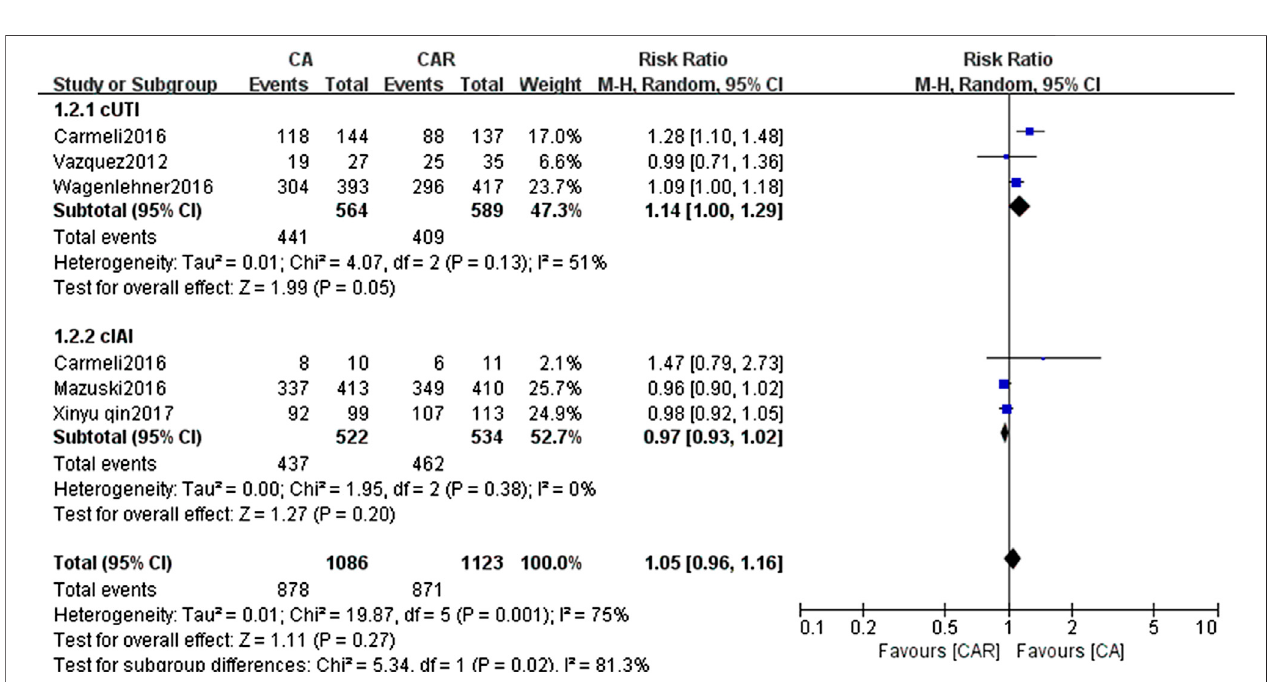
FIGURE 4 | Forest plots showing relative risk with 95% con fi dence interval of microbiological success in a random-effects model. cUTI, complex urinary tract infection; cIAI, complicated intra-abdominal infection; CA, ceftazidime/avibactam; CAR, carbapenems.